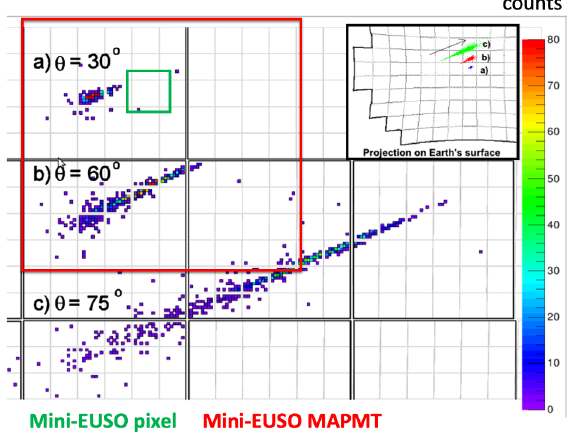
Figure 1. Comparison between JEM-EUSO and Mini-EUSO FoVs. The figure shows the detected light track of three sim- ulated EAS with ESAF [19] of energy 10 20 eV with di ff erent zenith angles ( θ = 30 ◦ , 60 ◦ , and 75 ◦ ) as imaged by JEM-EUSO detector. Each little colored dot represents the pixel FoV of JEM-EUSO projected on ground, each grey square indicates the MAPMT FoV and the large black squares show the FoV of JEM- EUSO PDMs. The green and red squares represent Mini-EUSO pixel’s and MAPMT’s FoV, respectively. Mini-EUSO pixel’s FoV is larger than the FoV of a JEM-EUSO MAPMT and Mini- EUSO MAPMT’s FoV is larger than the FoV of one JEM-EUSO PDM. Image adapted from